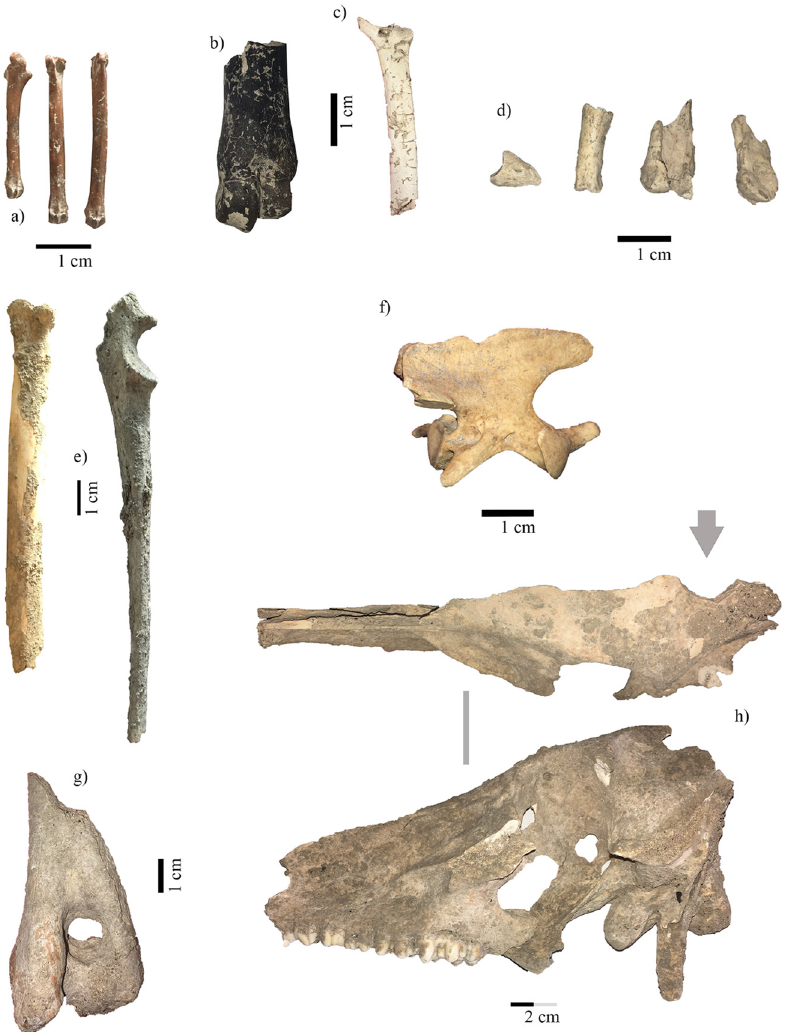
Figure 3: Selection of materials from pit 16: ( a ) Oryctolagus cuniculus metatarsals with burning in degree 2; ( b ) Sus sp. metapodial distal portion with burning in degree 3; ( c ) Sus sp. metatarsal 5 proximal portion with burning in degree 5; ( d ) Sus sp. phalanges with burning in degree 5; ( e ) Canis familiaris radius and ulna with concretions; ( f ) Canis sp. axis; ( g ) Sus cf. domesticus humerus distal portion; ( h ) Sus sp. cranium left half with anthropogenic